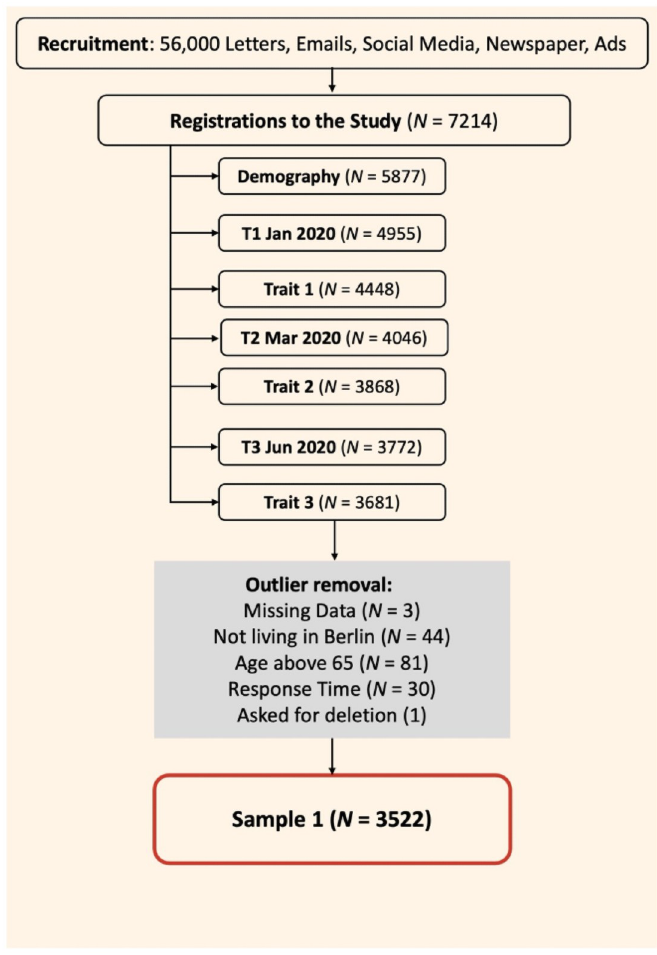
Fig 1. A depiction of the recruited sample, dropouts at every stage of the first phase of the study, and the process of reaching the final sample. Sample 1 indicates the final sample of participants that completed the first three assessment timepoints